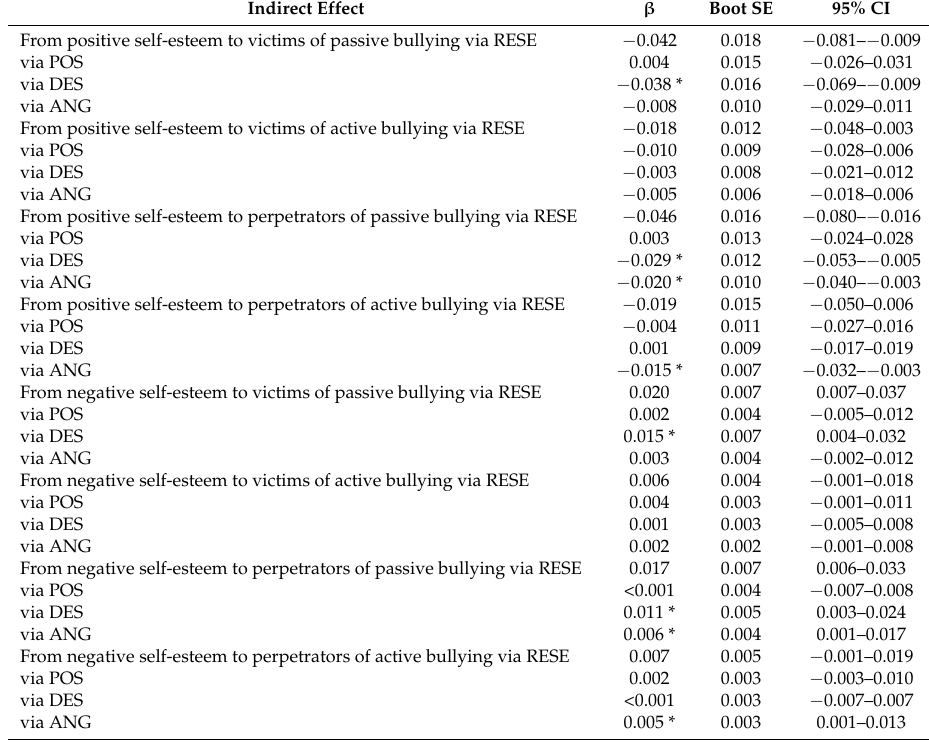
Figure 2. The mediation model of RESE (the SEM provided acceptable indices of goodness-of-fit, GFI = 0.966, CFI = 0.942, RMSEA = 0.075. The path weights in the graph were standardized.). Table 1. The mediating effect of RESE on the association between self-esteem and school bullying Indirect Effect β Boot SE 95% CI